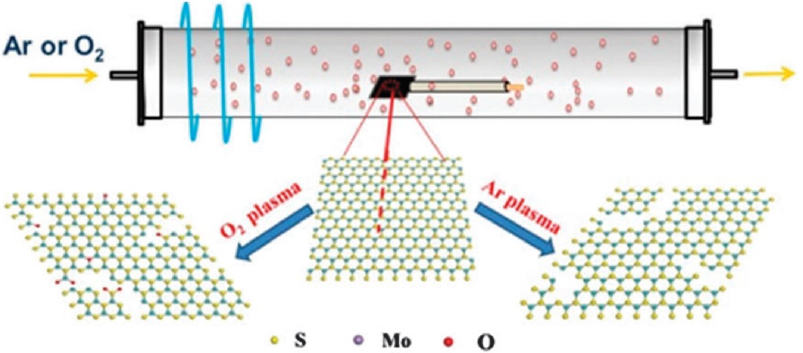
Figure 6. The development of defect sites in the MoS 2 thin films after O 2 or Ar plasma treatment [43].